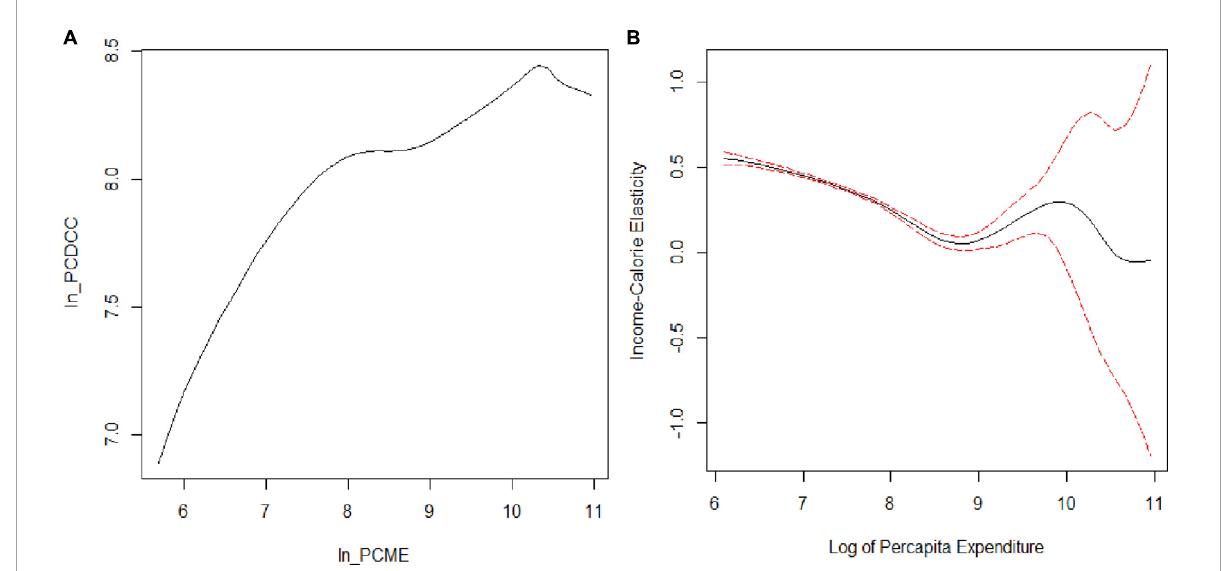
FIGURE1 Non-parametric estimation of calorie–income relationship. (A) Calorie–expenditure curve and (B) income–calorie elasticity.